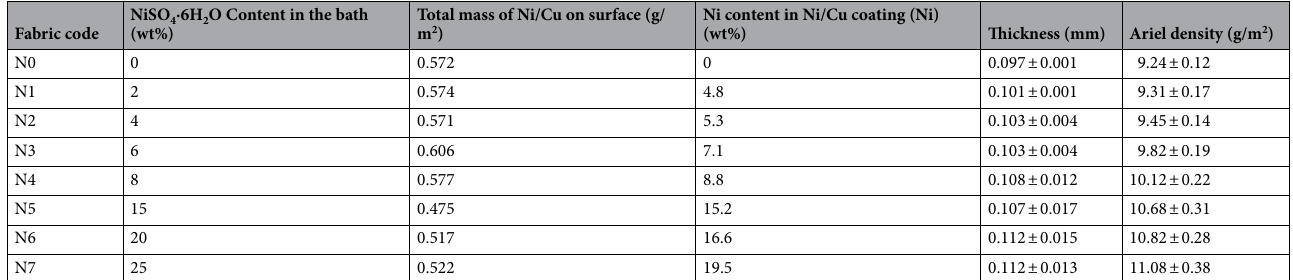
Table 1. Various properties of ultra-light Ni/Cu coated polyester fibrous materials.